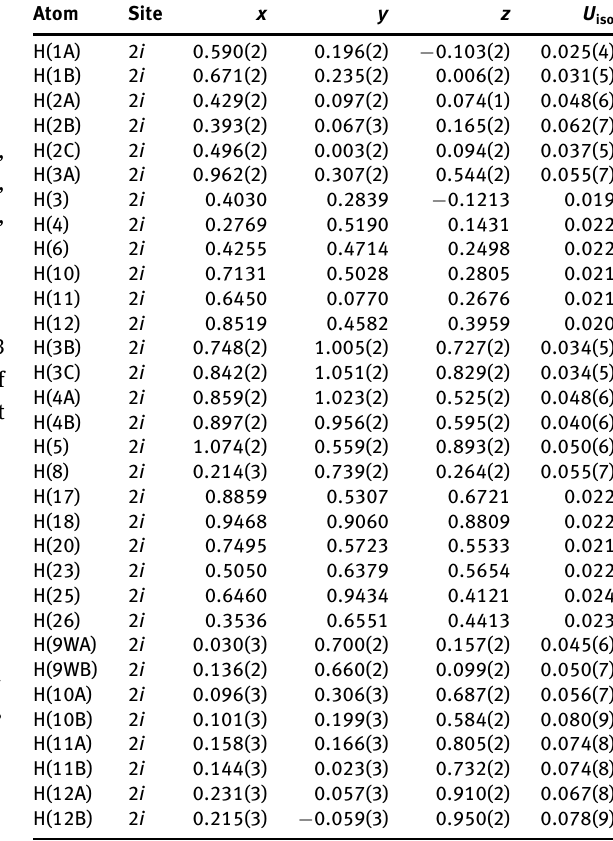
Table 2: Fractional atomic coordinates and isotropic or equivalent isotropic displacement parameters (Å 2